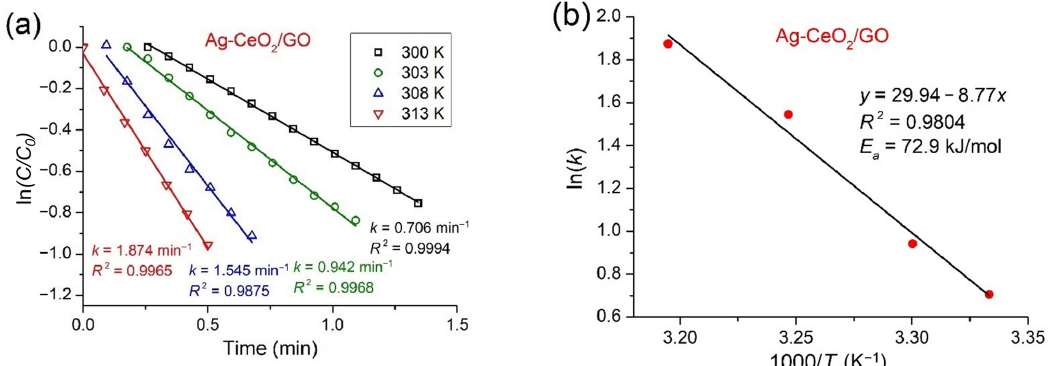
Figure 8. Plot of the 4-NP relative concentration logarithm ln( C / C 0 ) versus the reaction time at different temperatures ( a ) and Arrhenius plot of ln( k ) versus 1000/ T ( b ) for the Ag-CeO 2 /GO catalysts. Experimental conditions: C (4 ‐ NP) = 7.5 × 10 –5 M, C (NaBH 4 ) = 0.015 M, C (catalyst) = 0.015 g/L.